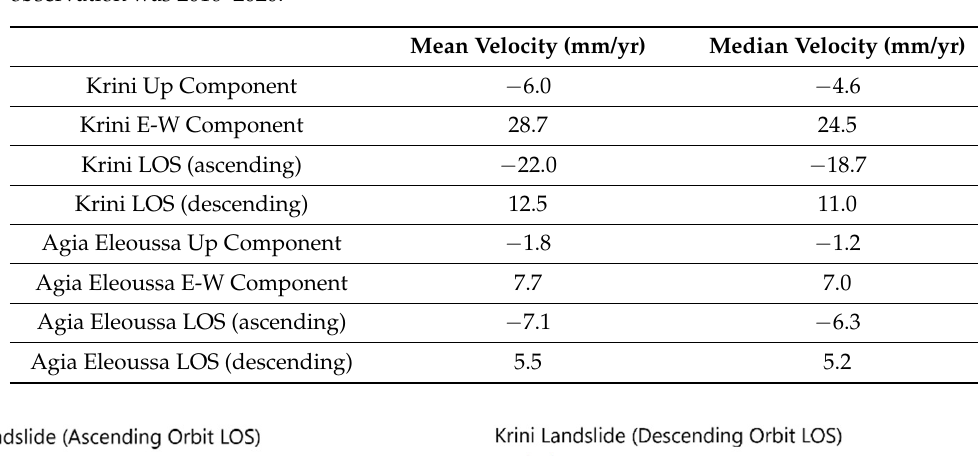
Table 1. Table of mean and median velocities of active landslides in the village of Krini and at the monastery of Agia Eleoussa. The landslide outlines are shown in Figure 6e, f. The period of observation was 2016–2020.